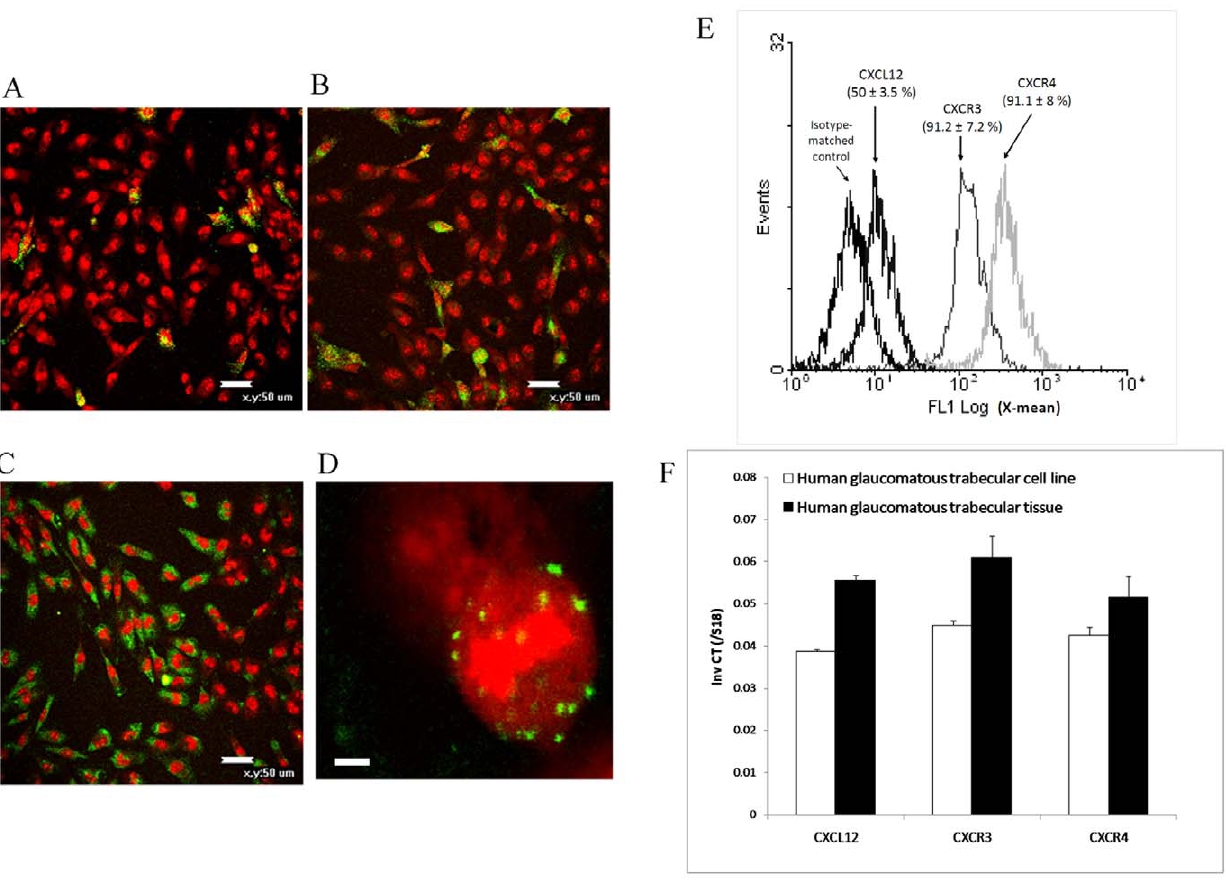
Figure 1. CXCL12, CXCR3, and CXCR4 expression by human glaucomatous trabecular tissue and a trabecular cell line. (A–C) The chemokine CXCL12 (A) and receptors CXCR3 (B) and CXCR4 (C) are detected in unstimulated human glaucomatous trabecular cells HTM3 by indirect immunofluorescence (secondary antibody in green, propidium iodide in red, scale bar: 50 m m, magnification 6 200). (D) Chemokine receptor CXCR4 appears as distinct spots located at the cell membrane surface (scale bar: 5 m m, mag. 6 800). Representative images of three independent experiments are depicted. (D) Cell expression of CXCL12 and receptors is also detected and quantified by immunoflowcytometry. Representative results obtained over 6 independent experiments, mean 6 SEM of positive cells. (E) Chemokine and receptor mRNAs are detected in human glaucomatous trabecular tissues (n=15) and in the HTM3 trabecular cell line. Data in the bar graph are presented as means 6 SEM.